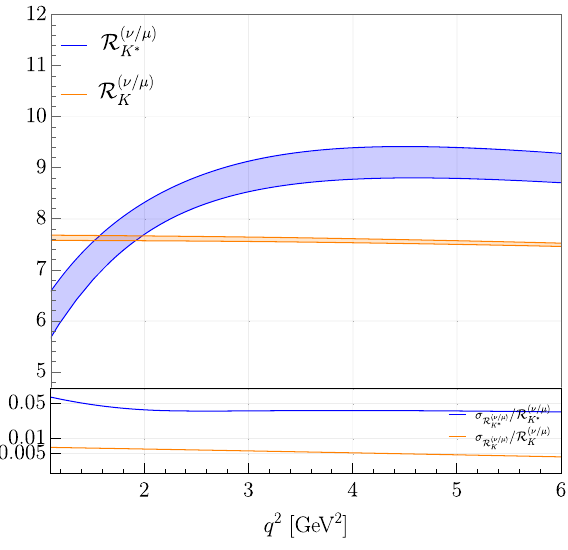
(ν/μ) (ν/μ) Fig. 4 The ratios R and R are plotted in orange and blue K K ∗ respectively, as functions of q 2 in the region well below the first c ¯ c resonance. In the lower panel we display the relative error in order to better appreciate the precision with respect to those shown in Figs. 2 and